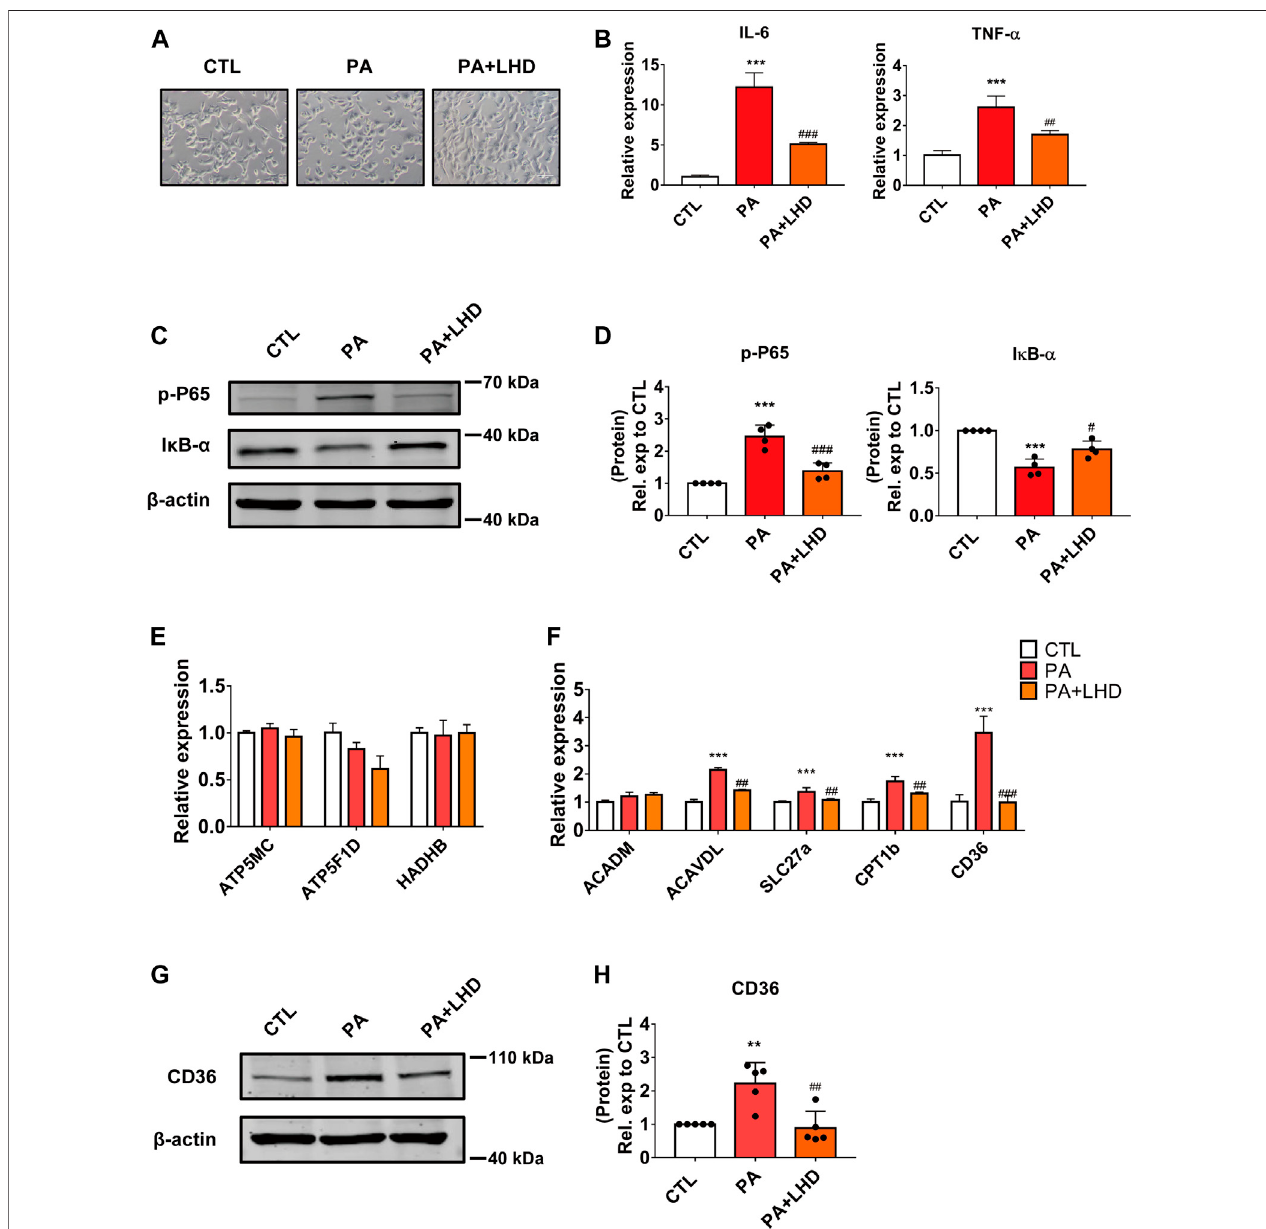
FIGURE 2 | LHD inhibits PA-induced cardiomyocyte in fl ammation in vitro . (A) Representative images of cell morphology captured by phase microscopy (20 × magni fi cation). n (cid:1) 3. (B) Effect of LHD treatment on pro-in fl ammatory gene expression in AC16 cells treated with PA for 16 h. *** p < 0.001, compared with the CTL group, ## p < 0.01, ### p < 0.001, compared with the PA group, n (cid:1) 3. (C,D) Changes in the intracellular in fl ammatory signaling pathway after LHD and PA treatment. (C) Western blotting analysis of the expression of the p-P65 and I κ B- α in fl ammatory signaling proteins in human cardiomyocytes; (D) Statistical analysis of protein expression, *** p < 0.001, compared with the CTL group; # p < 0.05, ### p < 0.001, compared with the PA group, n (cid:1) 4. (E,F) Cardiac mRNA expression of (E) oxidative phosphorylation-relatedenzymesand (F) fattyacidmetabolism-relatedgenes.*** p < 0.001,comparedwiththeCTLgroup; ## p < 0.01, ### p < 0.001,comparedwiththe PA group, n (cid:1) 3. (G,H) Western blotting analysis of the regulatory effect of LHD on CD36 expression. ** p < 0.01, compared with the CTL group; ## p < 0.01, compared with the PA group, n (cid:1) 5.